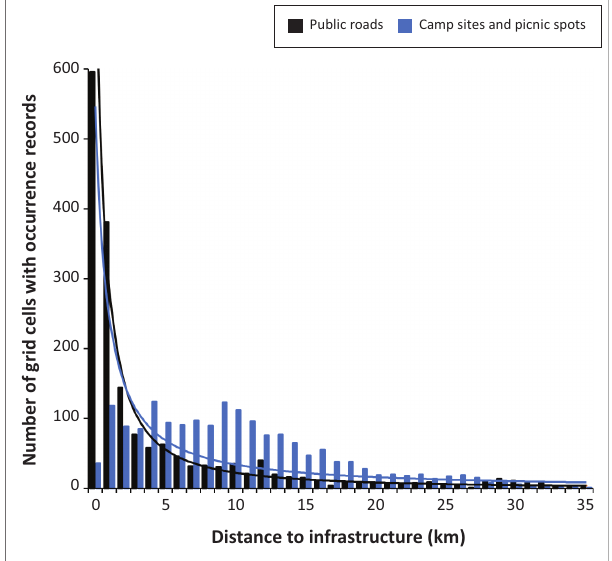
FIGURE 4: Distances of grid cells (1 km × 1 km) containing records to nearest publicly accessible infrastructure (camp sites, picnic spots and public roads) within the Kruger National